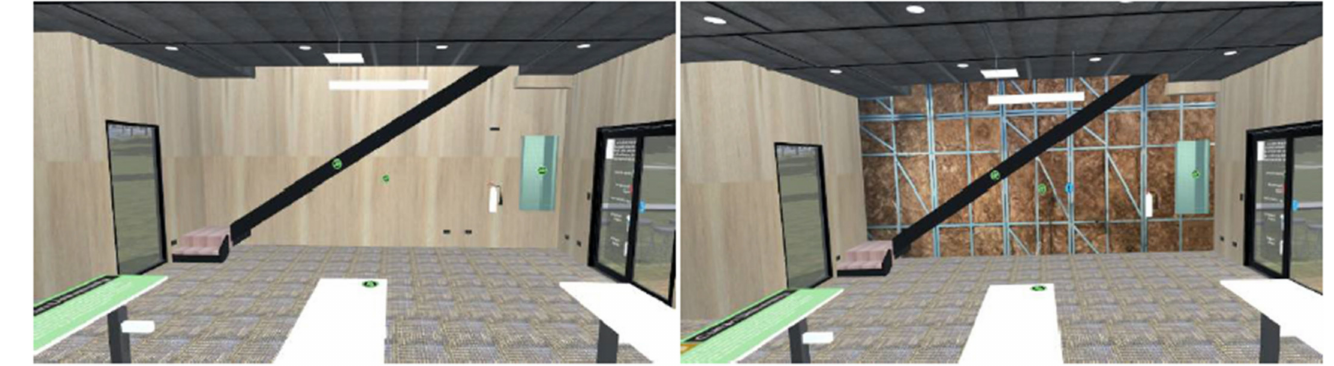
Figure 11. The VR model allows visualisation of the modular construction